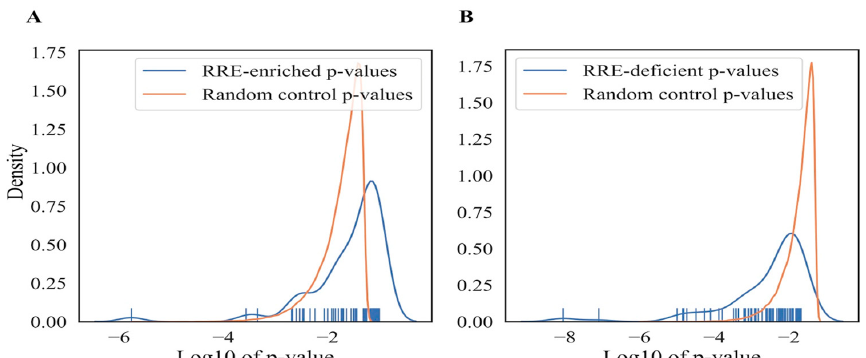
Figure 5. Random control of GO terms enrichment in RRE-enriched ( A ) and RRE - deficient ( B ) gene sets.